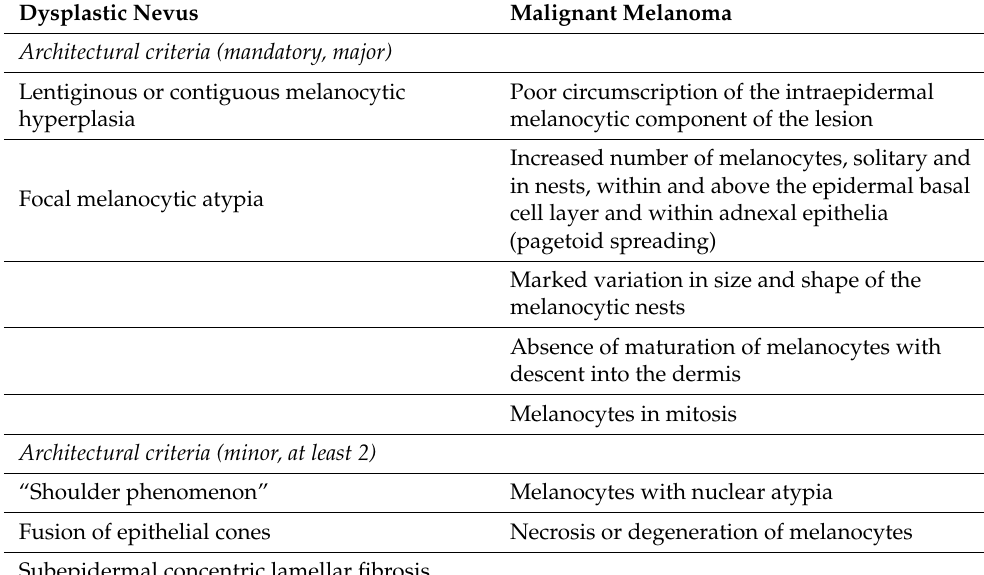
Table 1. Summary of these